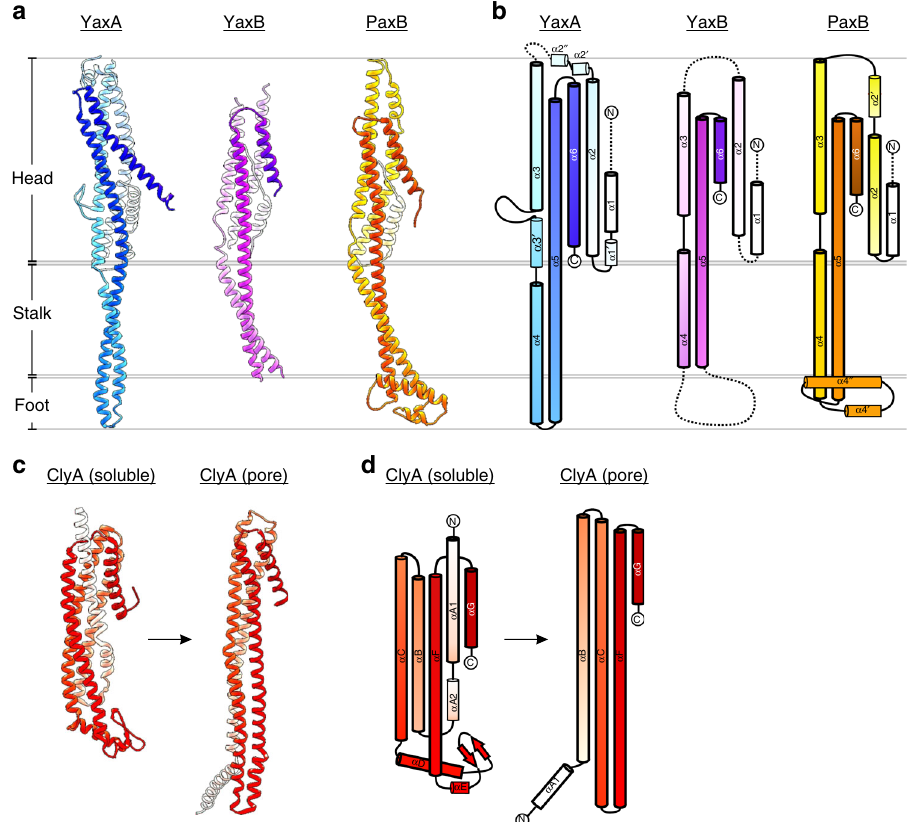
Fig. 1 Structures of YaxA, YaxB, and the YaxB orthologue PaxB. a Crystal structures of YaxA (blue), YaxB (pink), and the YaxB orthologue PaxB (orange). Ribbons are shaded from light (N-terminus) to dark (C-terminus). All three proteins partition into a helix bundle head domain, a pronounced coiled-coil stalk and a foot domain. Two helices α 4 ′ and α 4 ″ of PaxB comprise the lytic moiety of the toxin and will be mentioned throughout the manuscript. b Topology diagrams of YaxA, YaxB, and PaxB colored according to a . α 1- α 6 in bold black outline denote the structural frame common to both toxin subunits YaxA and YaxB/PaxB. Helices in thinner black outline are unique for the respective protein. Dotted lines signify protein regions unresolved in the crystal structures. c Crystal structures of ClyA in its soluble form (PDB code 1QOY) and as a pore-protomer (PDB code 2WCD). The cartoons are to-scale with those in a . d Topology diagrams of ClyA in soluble and pore-protomeric states colored according to c . Helices are assigned according to previous nomenclature 12 . Helices boldly outlined in black correspond putatively to helices α 1- α 6 of the YaxAB system illustrated in